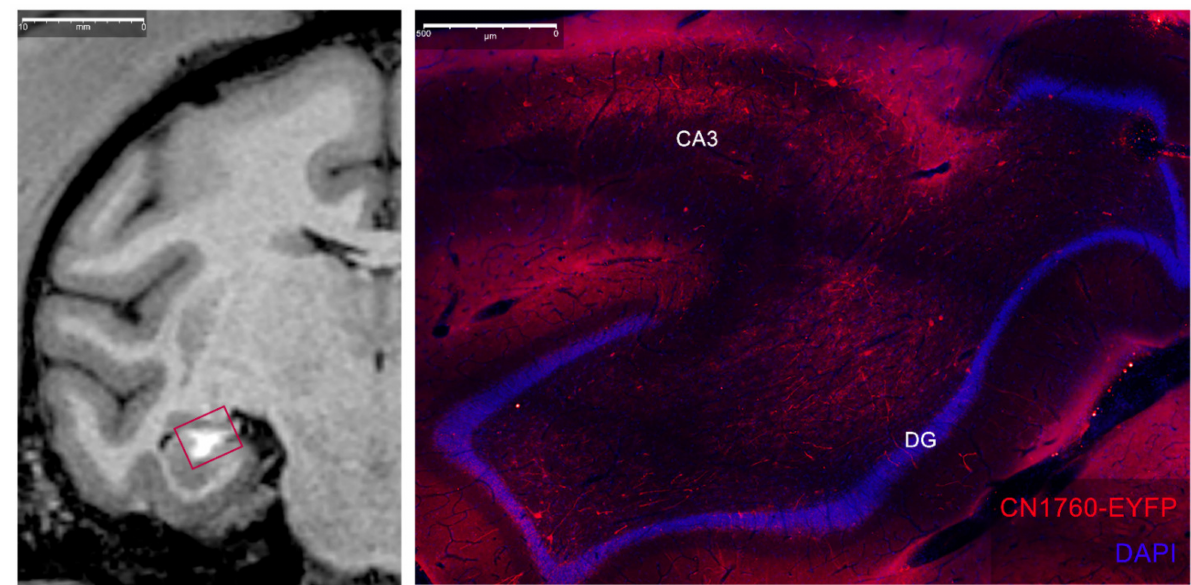
Figure 8. Comparison of Mn 2+ MRI signal ( left ) and local expression of virus ( right ) after a hip- pocampal injection in case MTL4-L. Right-imaged region highlighted with red square in MRI ( left ). Our virus used a GABA-specific enhancer to selectively target interneurons, as evidenced by a lack of red pyramidal cell body labeling in CA3 and granule cell body labeling in the dentate gyrus (DG). We tagged infected interneurons and associated fibers with red-shifted fluorophores (anti-EYFP, ThermoFisher, Waltham, MA, USA) and cell bodies were non-selectively labeled using a DAPI stain (ThermoFisher, Waltham, MA, USA). (Viral construct CN1760: